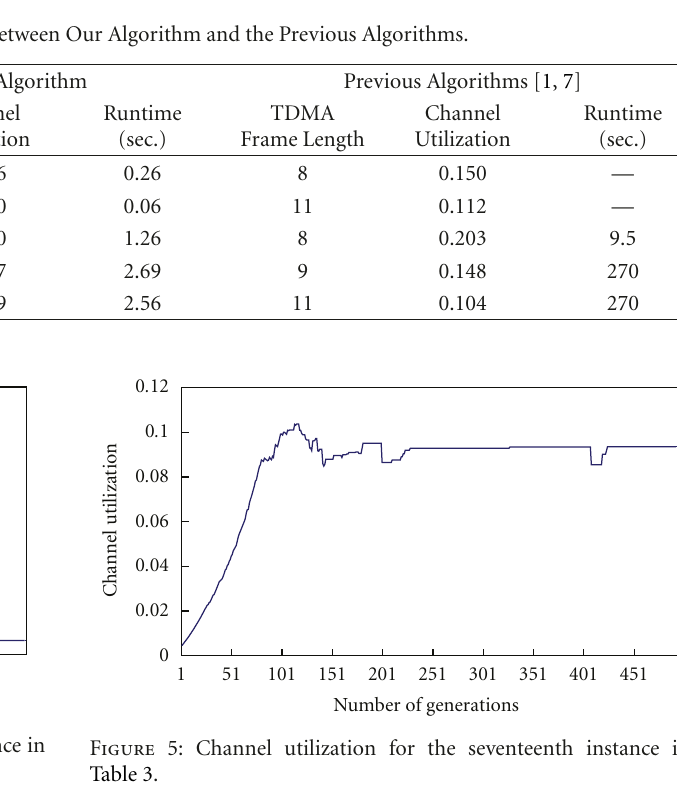
percent of the computation time of the previous